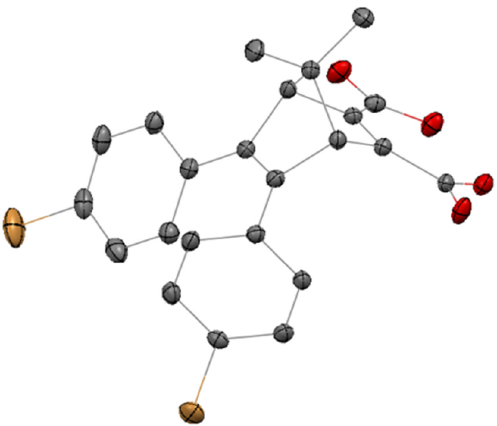
Figure 2. Single crystal structure of 5,6-bis(4-bromophenyl)-7,7- dimethylnorbornadiene-2,3-dicarboxylic acid (8) as its sodium salt. Hydrogen atoms, sodium ions and solvent molecules are omitted for clarity. The structure is shown with 50% probability